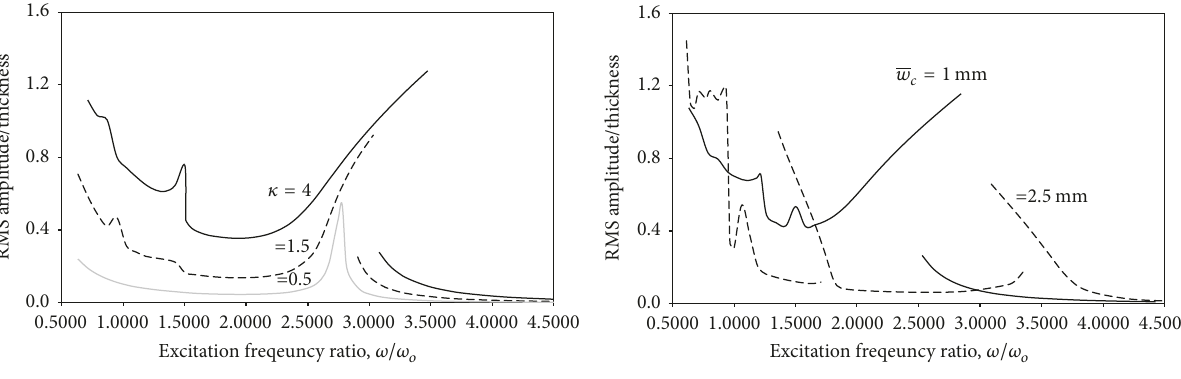
(b) Vibration amplitude versus excitation frequency for various curvatures ( ℎ = 2 mm, 𝐿 𝑥 = 0.5 m, 𝐿 𝑥 = 0.6 m, 𝐵 = 0.4 m, 𝜉 = 0.02 , 𝜅 = 4 )